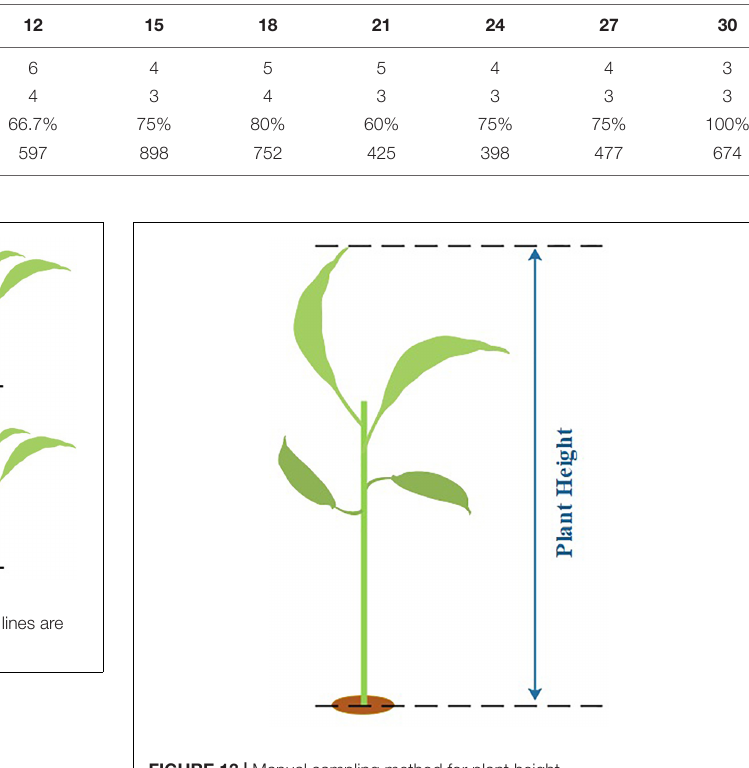
FIGURE 13 | Manual sampling method for plant